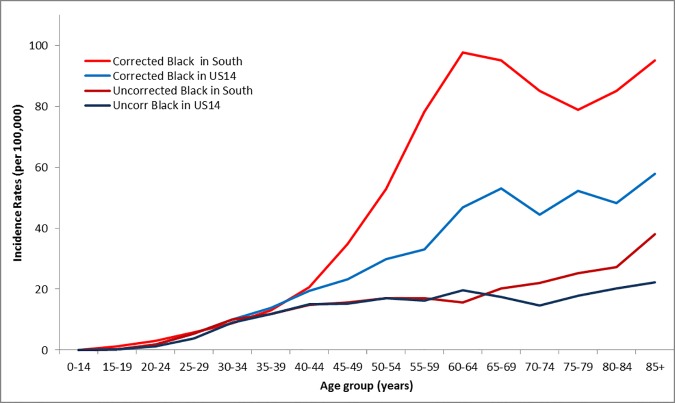
Age-specific cervical cancer incidence rates of black women pre- and post- US hysterectomy prevalence rate correction (2008–2012).Abbreviations: NHB–non-Hispanic black.